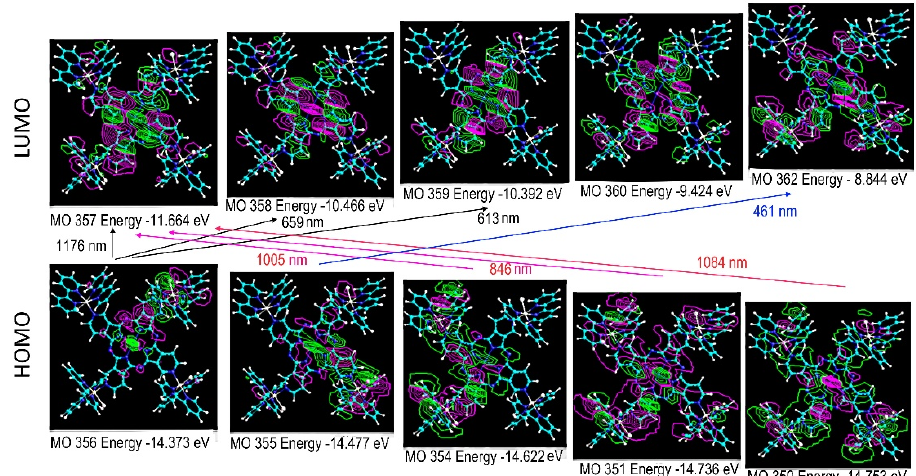
Figure 4. ZINDO/S molecular orbital representations for HOMO and LUMO orbitals of TRuCo(III)TPyPz and the corresponding electronic transitions at 461 (oscillator strength f = 0.116), 613 (0.136), 659 (0.192), 846 (0.588), 1005 (0.375), 1084 (0.215) and 1176 (0.156) nm.